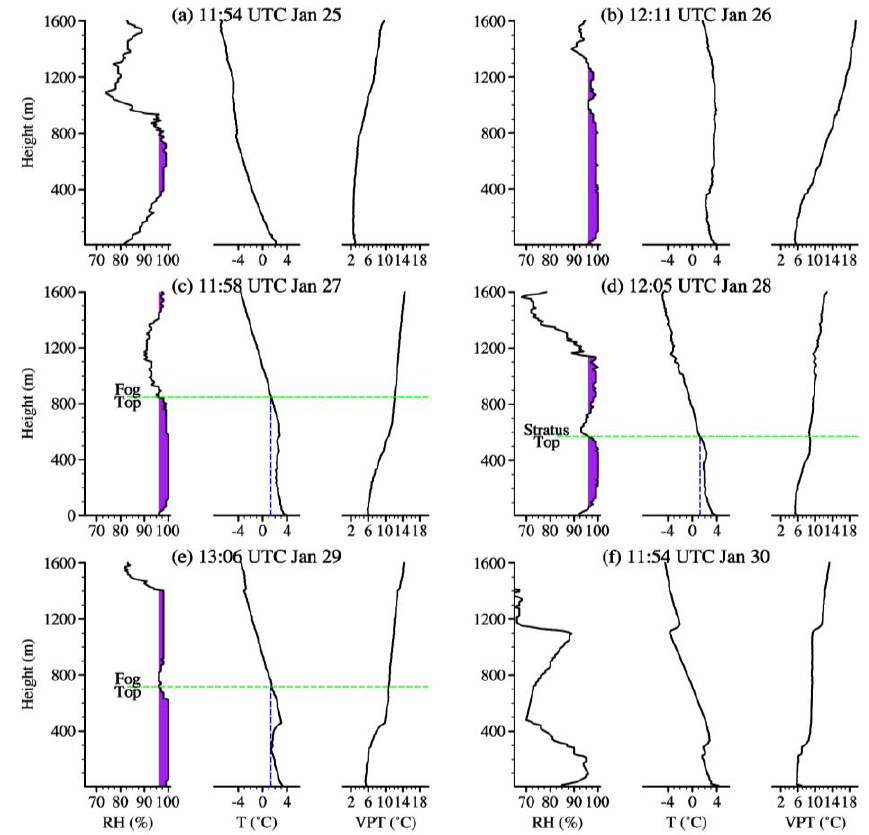
Figure 4. Atmospheric boundary layer structure around 1200 UTC from 25–30 January 2017 ( a – f ): relative humidity (RH; %), temperature (T; °C), and virtual potential temperature (VPT; °C). The purple shading indicates relative humidity ≥96%, meaning fog, stratus, or stratocumulus. The green dotted line represents the top of the fog (stratus), and the blue dotted line links the temperature of the top of the fog to the horizontal axis.